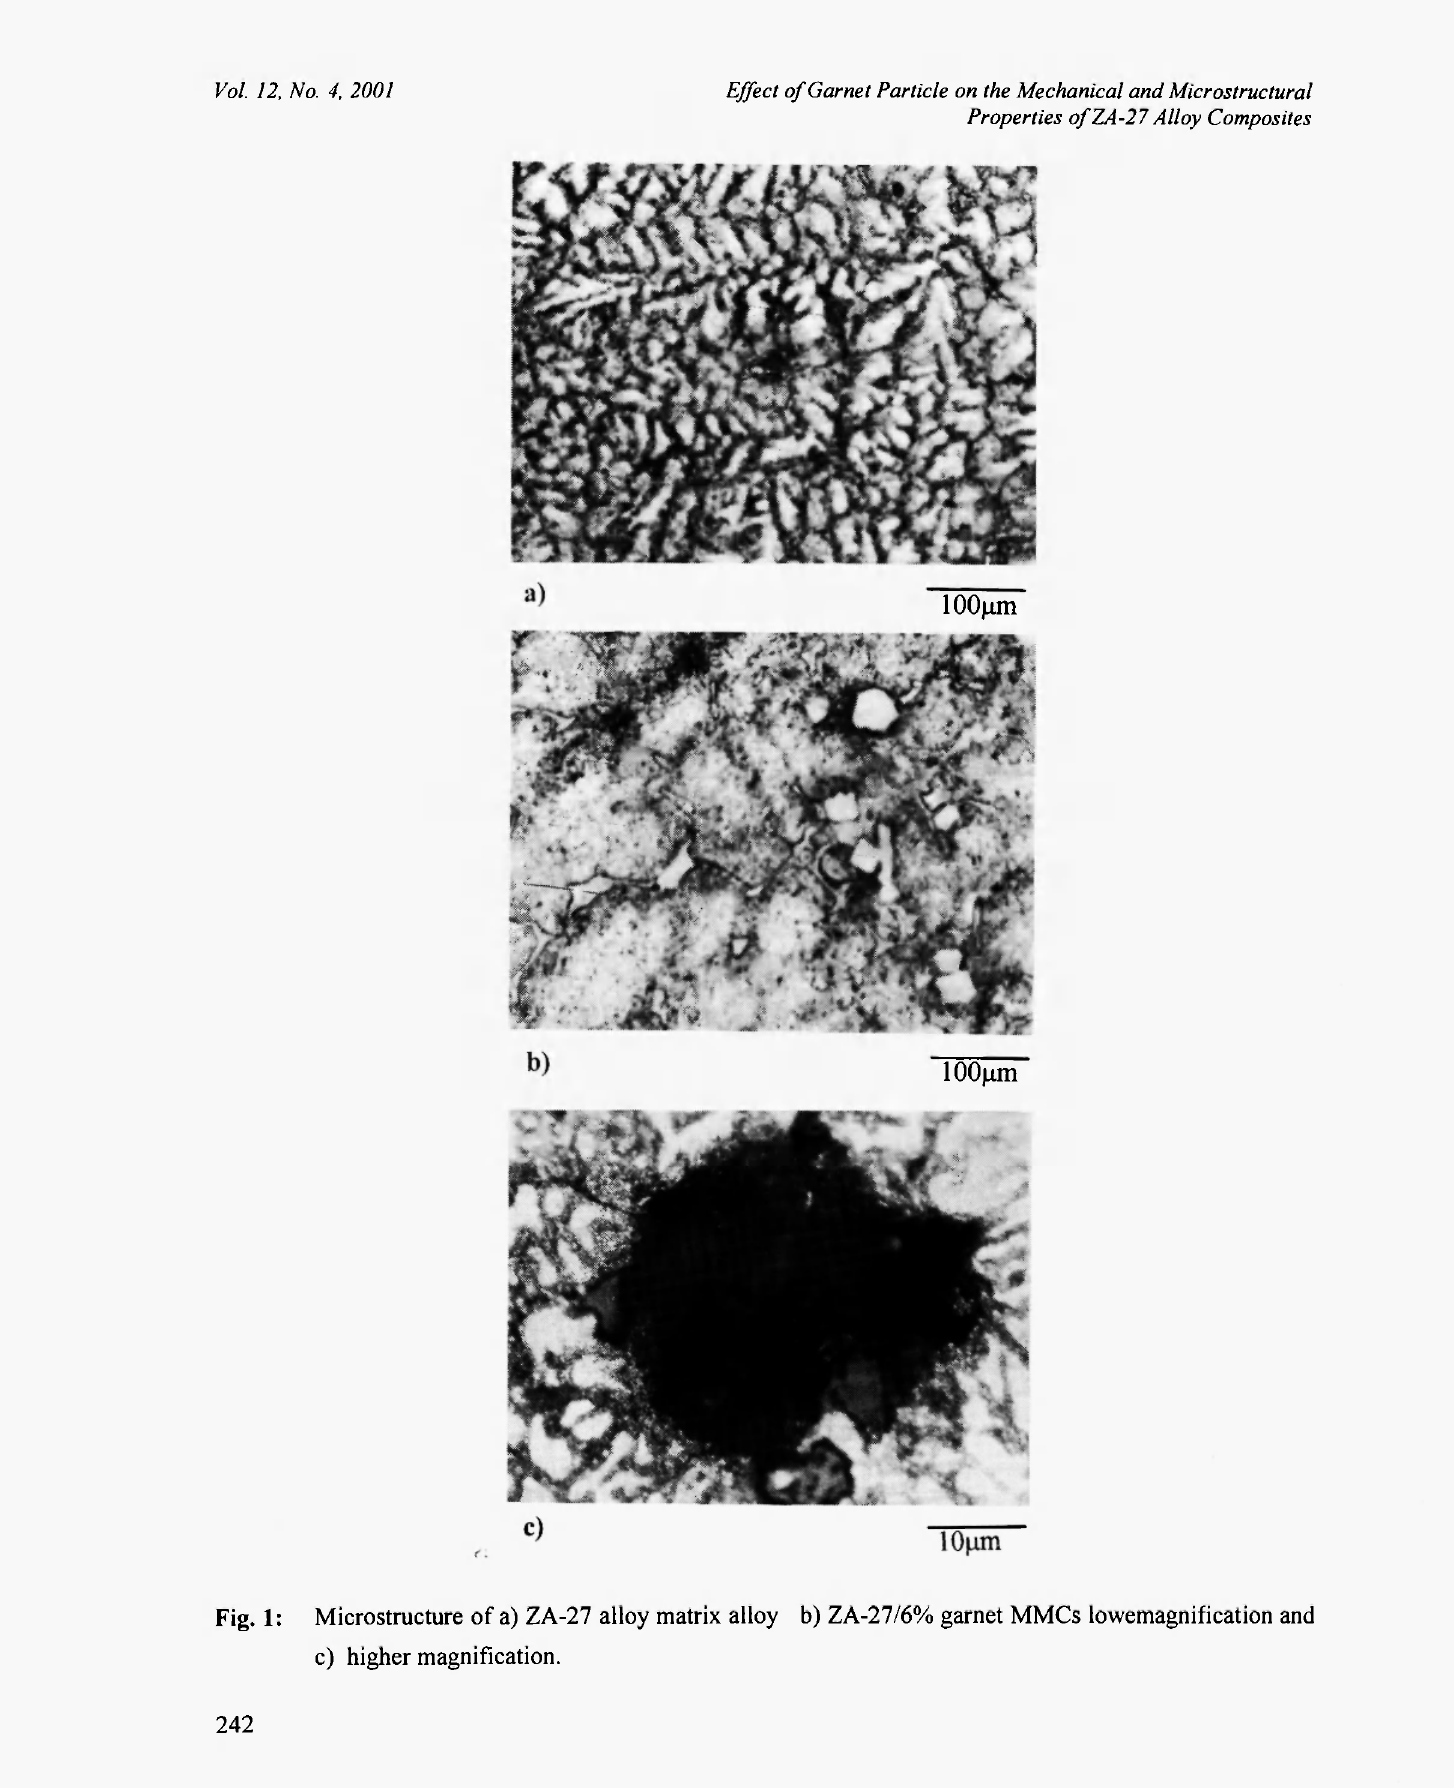
Fig. 1: Microstructure of a) ZA-27 alloy matrix alloy b) ZA-27/6% garnet MMCs lowemagnification and c) higher